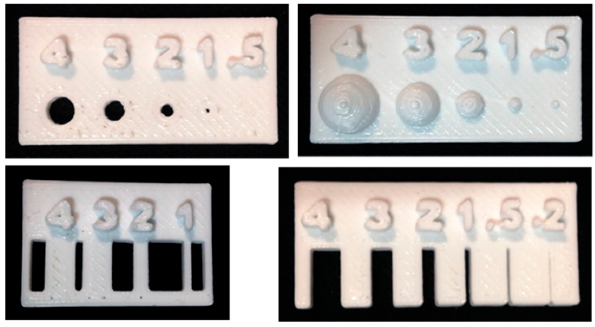
Figure 4. Photographs of the four printed test objects, with variable hole sizes ( top left ); variable hemispheres ( top right ); lines ( bottom left ) and slits ( bottom right ).